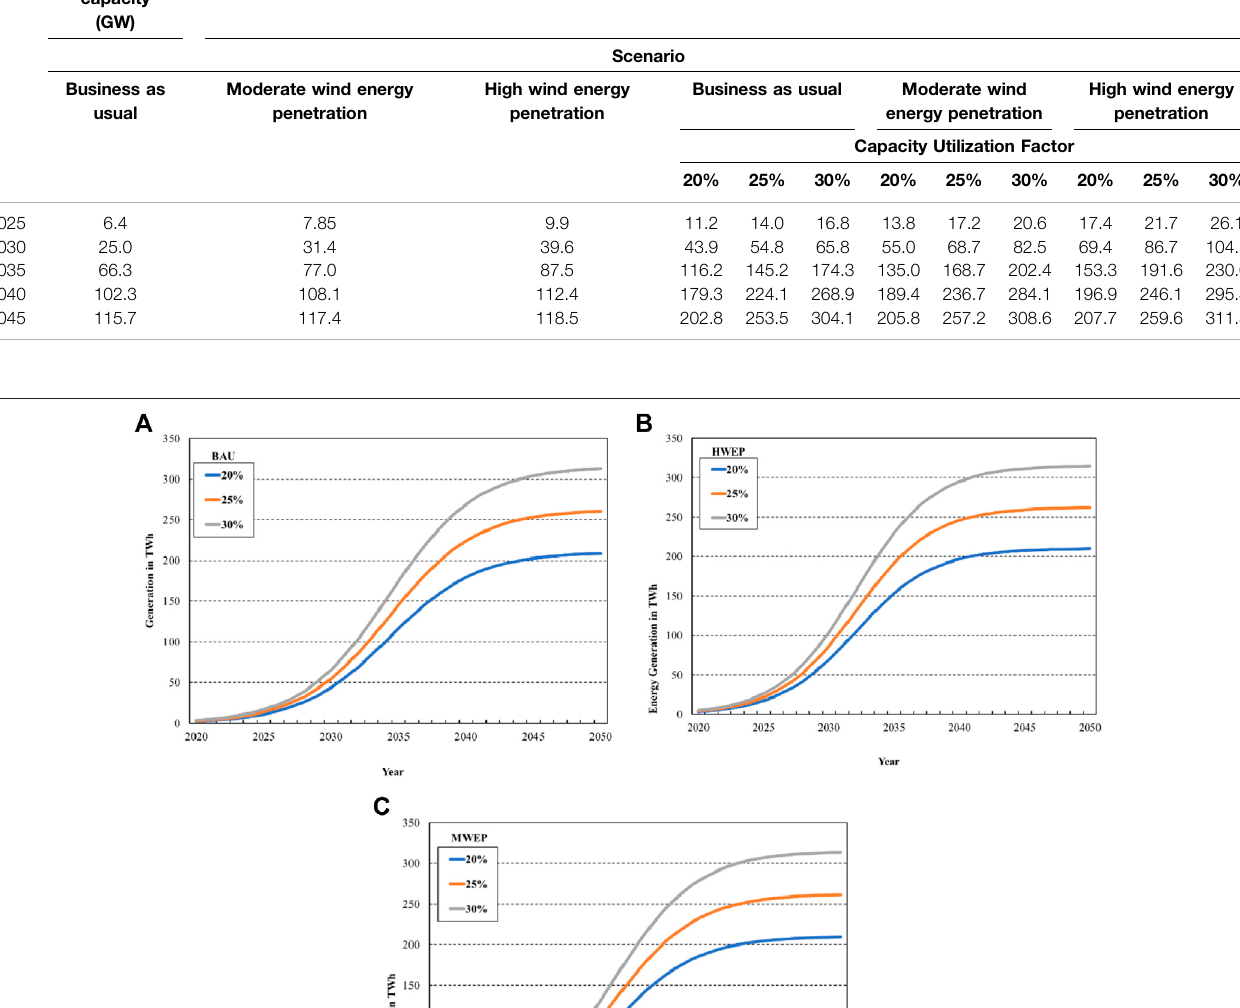
Frontiers in Energy Research |